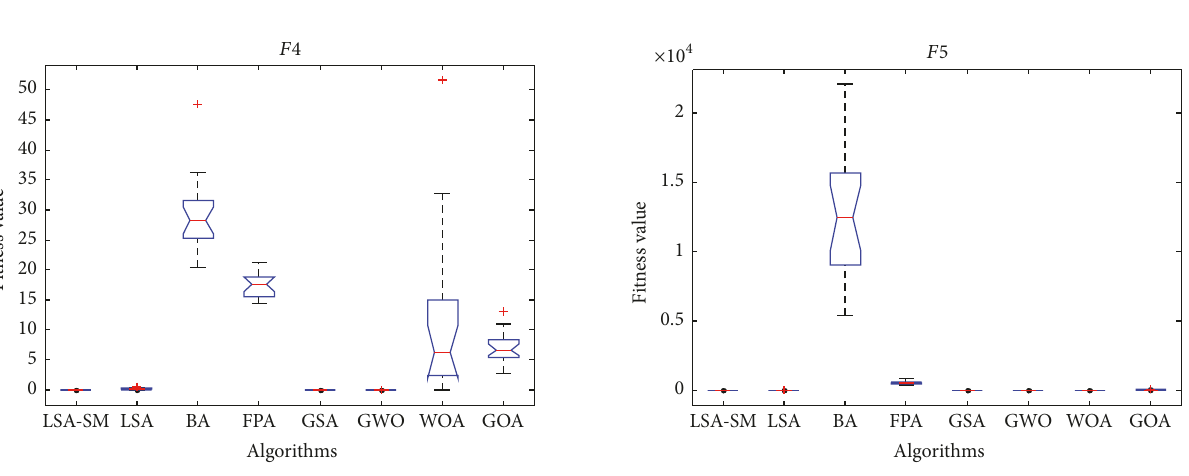
Figure 26: 𝐷 = 30 , ANOVA test of global minimum for 𝑓 04 . Figure 27: 𝐷 = 30 , ANOVA test of global minimum for 𝑓 05 .